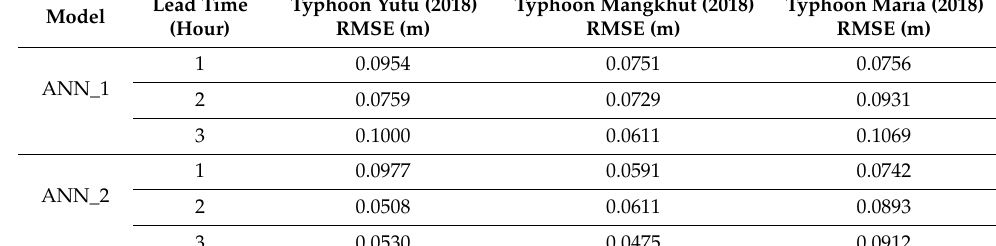
Table 6. Comparison of RMSEs for different ANN models and historical typhoon events.